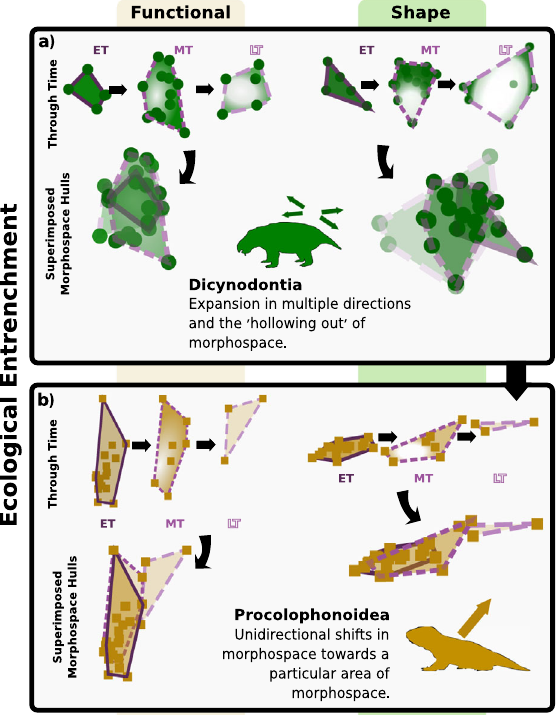
Fig. 6 Ecological entrenchment illustrated using morphospace occupation through time. Two main patterns of ecological entrenchment observed within early Mesozoic herbivores: a The increasing specialisation of taxa concentrates diversi fi cation at the peripheries of morphospace, leading to the hollowing out of total morphospace occupation (as shown here in dicynodonts). b A unidirectional shift showing clear specialisation towards a speci fi c eco-morphology (as shown here in procolophonoids). Morphospace areas from each epoch are shown in isolation and overlaid over each other to highlight the shifts through time. Epochs: EJ Early Jurassic, ET Early Triassic, LT Late Triassic, MT Middle Triassic, All silhouettes created by S.S., but some are vectorised from artwork by Felipe Alves Elias (https://www.paleozoobr.com/) and Jeff Martz (United States National Park Service), available for academic use with well as the aetosaurs, which had been important elements within Norian faunas (Fig. 3c). We fi nd that these taxa actually began to decline during the Norian (Fig. 5). The decline in these formerly